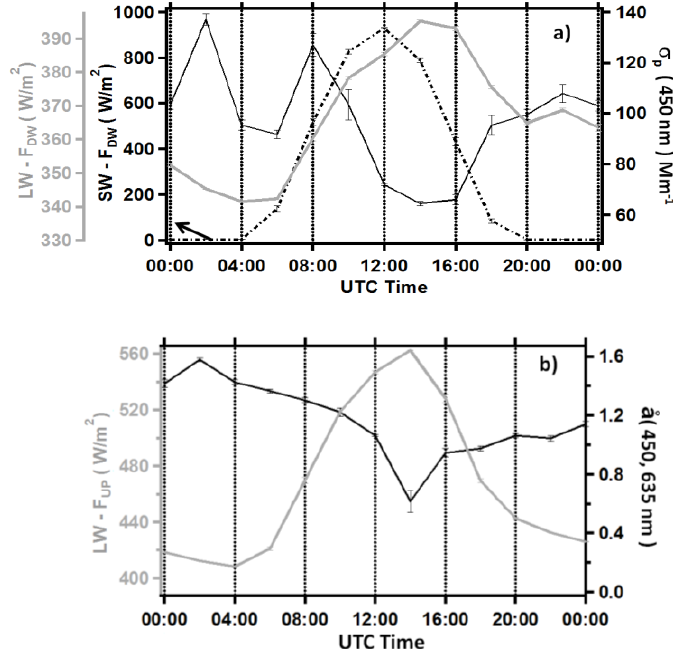
Figure 8. ( a ) Daily evolution of the two hour-averaged values of σ p (black solid line), SW-F DW (black dotted line), and LW-F DW (grey solid line) on 6 May 2015; ( b ) Two hour-averaged å (450, 635 nm) (black line) and LW-F UP (grey line) daily evolution on 6 May 2015. The error bars represent the corresponding SEMs.